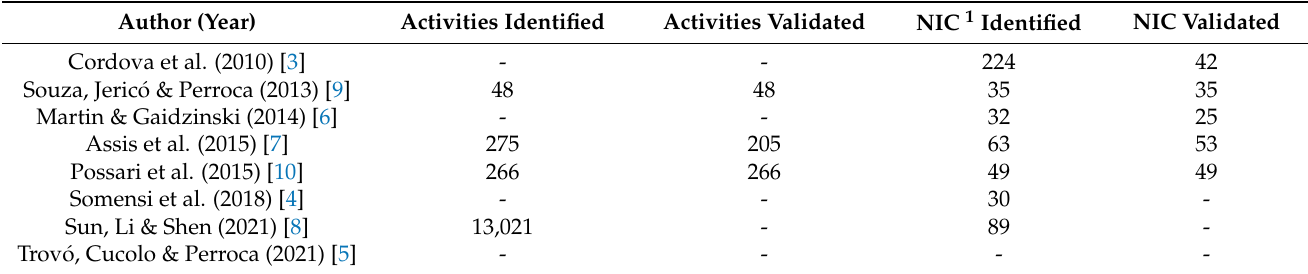
Table 2. Number of activities and interventions identified and